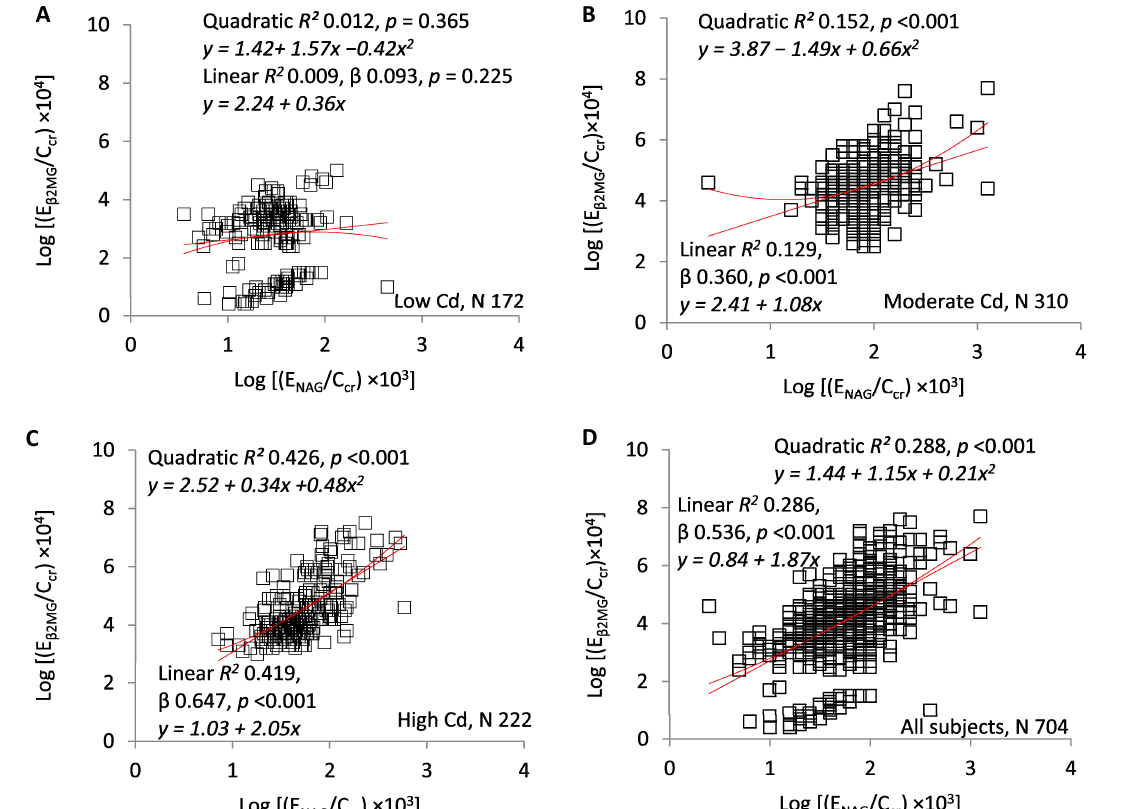
Figure 5. E NAG / C cr as a predictor of E β 2MG / C cr. Scatterplots compare log[(E NAG / C cr ) × 10 3 ] to log[(E β 2MG / C cr ) × 10 4 ] in subjects grouped by locality ( A – C ) and in all subjects ( D ). Quadratic and linear coefficients of determination ( R 2 ) are provided together with corresponding equations, standardized β coefficients, and p -values.